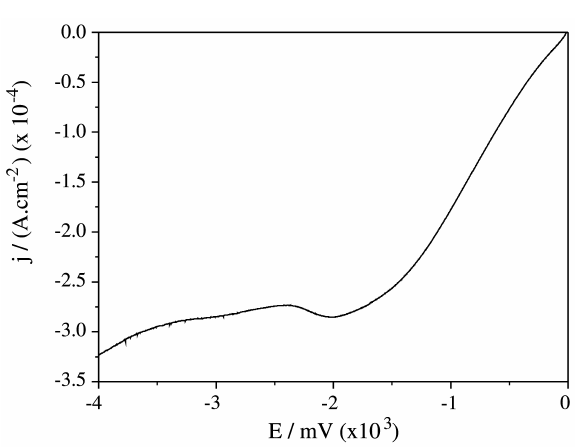
Figure 3. Linear voltammetric curves for Cd 2+ reduction at a glassy carbon rotating disc electrode coated with PPy 0 . Aerated 10 mg L -1 Cd 2+ ion in pH 4.8 sulfuric-sulfate solution. Potential scans from Esa = 0.00 V to Esc = -4.00 V at 0.02 V s -1 , at static conditions. Table 1. Effect of the electrode material on the Cd 2+ ion removal efficiency at several applied potentials, after 90 min electrolysis. Aerated